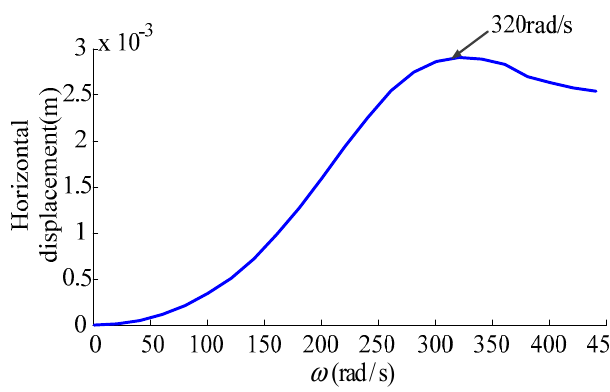
Figure 2. Amplitude response curve of the system.